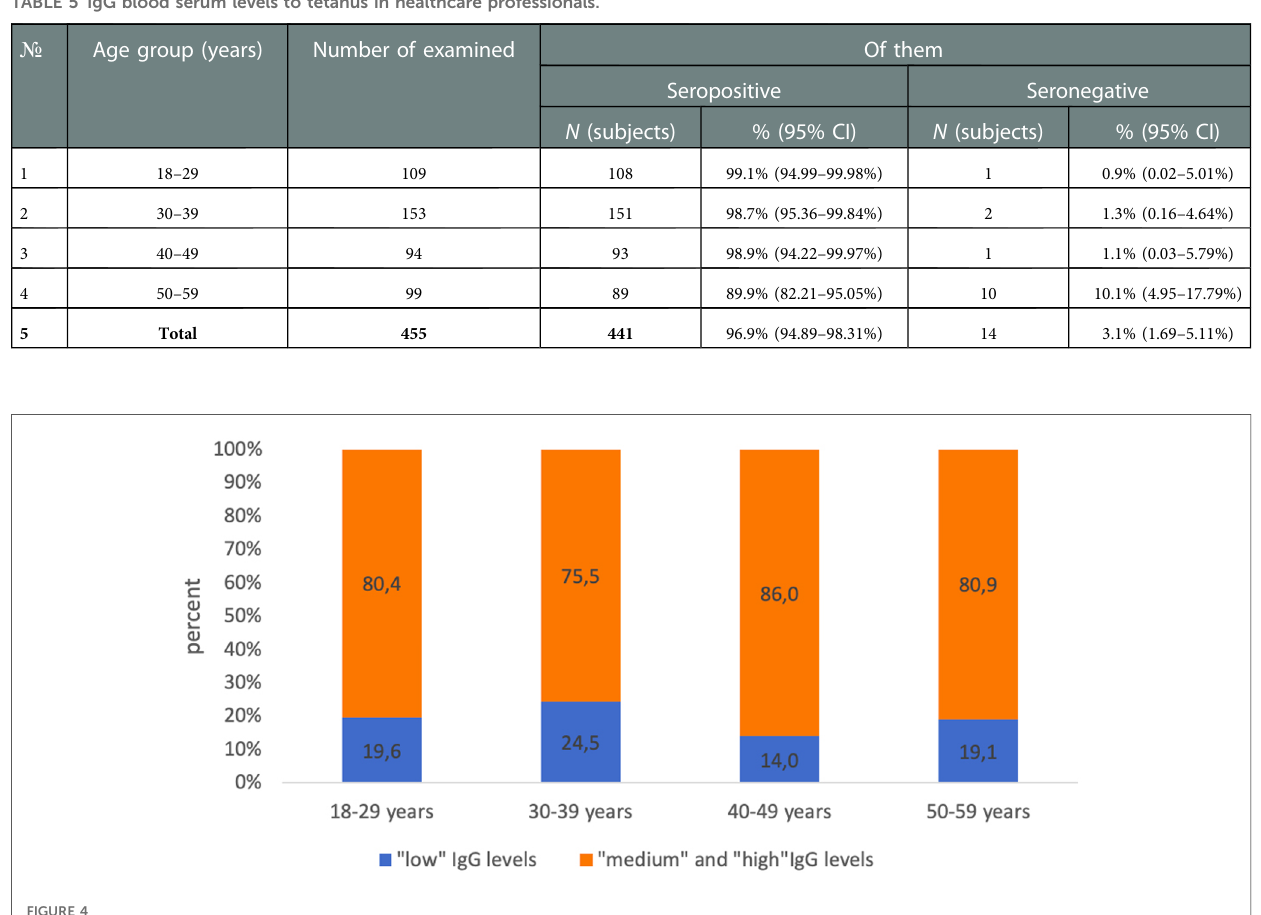
TABLE 5 IgG blood serum levels to tetanus in healthcare professionals.